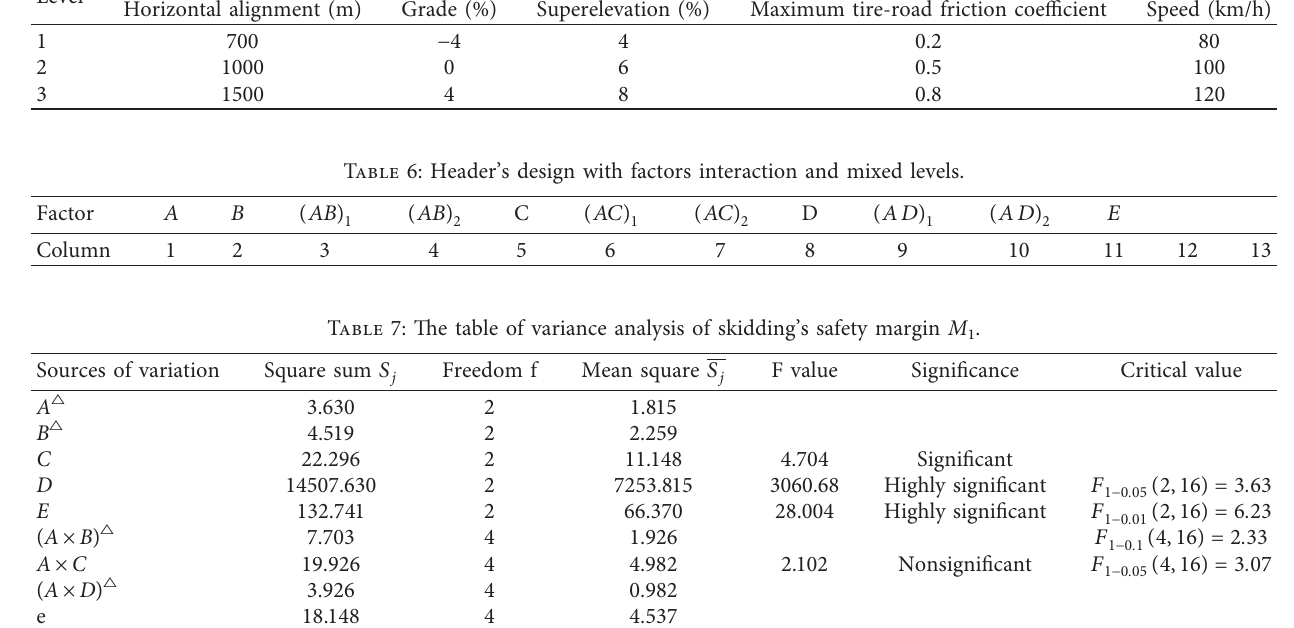
Table 8: The table of variance analysis of rollover’s safety margin M